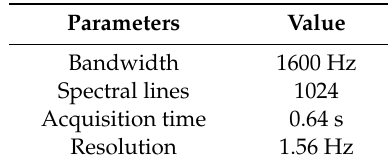
Table 2. The experimental parameters.